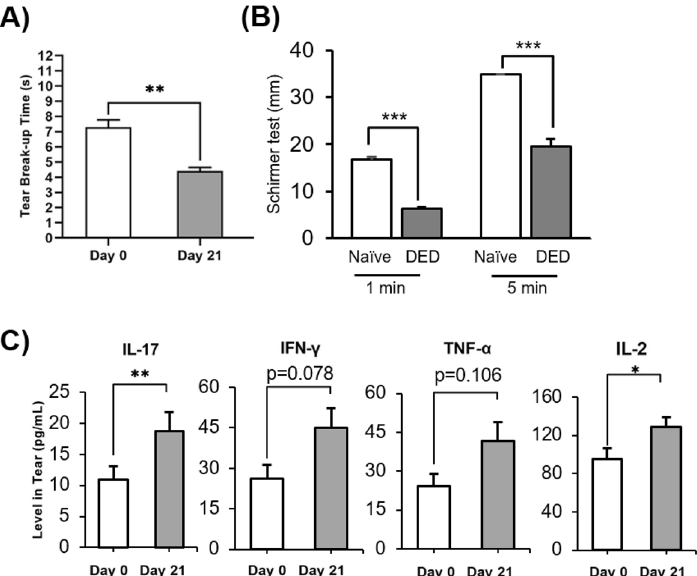
Figure 3. TFBUT, tear volume and cytokine levels in tears. ( A ) Bar chart showing TFBUT, measured by the time interval between complete blink and appearance of the first dry spot, on days 0 and 21 following controlled environment room exposure. ( B ) Bar chart quantifying tear volume in naïve and post-DED induction primates at 1 and 5 min of Schirmer test. ( C ) Tear wash was collected on days 0 and 21 of the controlled environment room housing (25 µL/wash) to measure the levels of proinflammatory cytokines, IL-17, IFN-γ, TNF-α, and IL-2. Representative data from two independent experiments are shown; each experiment consisted of 6 monkeys (n = 12 eyes). Data are represented as mean ± SEM (error bar). T-test; * p < 0.05, ** p < 0.01, *** p <